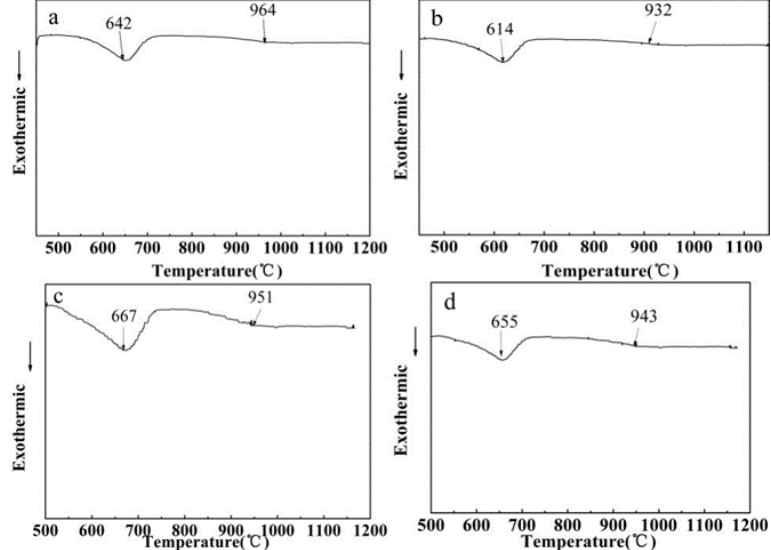
Figure 4. Differential scanning calorimetry (DSC) of the TA–Si x filler metals during the melting process: ( a ) x = 0%; ( b ) x = 0.5%; ( c ) x = 1.0%; ( d ) x = 2.0%.